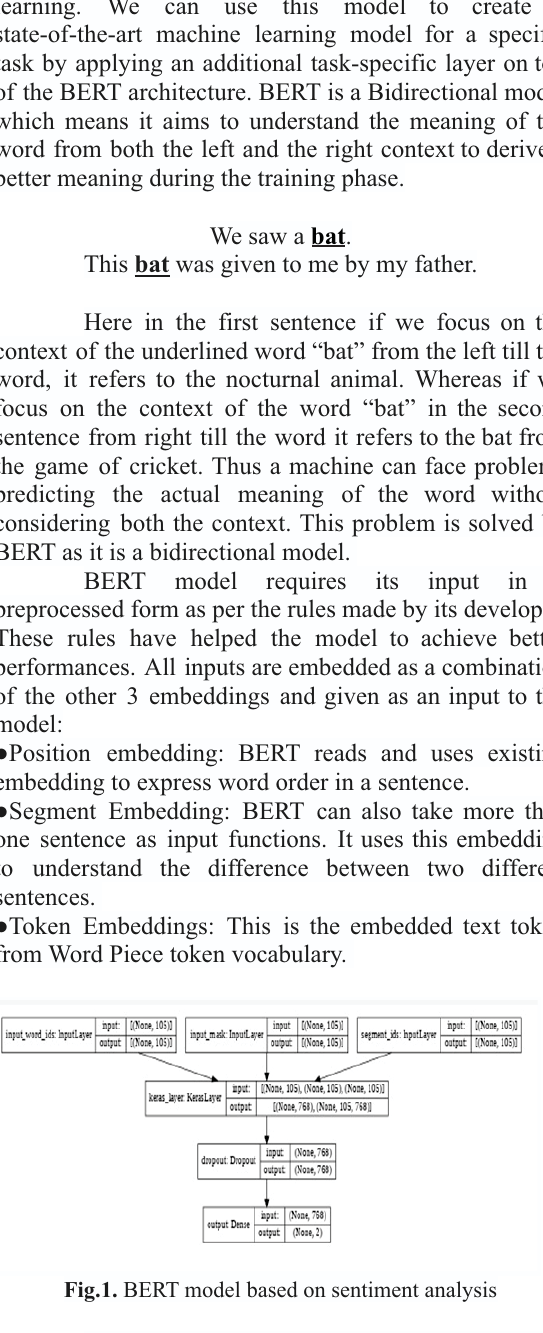
Fig.2. BERT model flow chart based on sentiment analysis